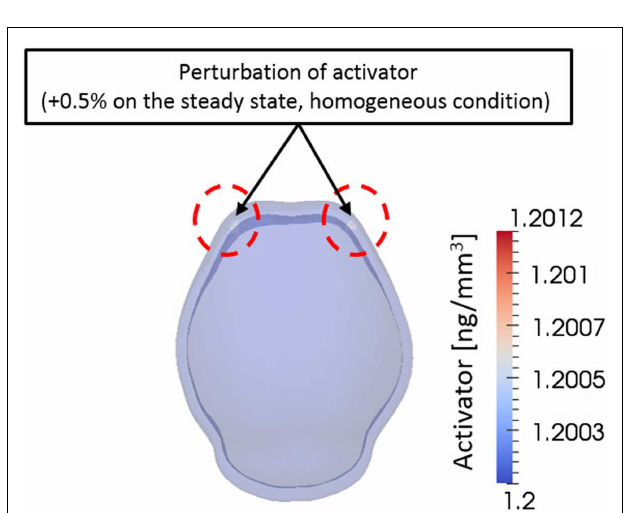
toward the top while the caudal end of the skull is at bottom. (B) Only parts of cranial vault are considered. (C) Surface surrounding the cranial vault is made. (D) Shell-shaped domain around the surface and mesh are generated.